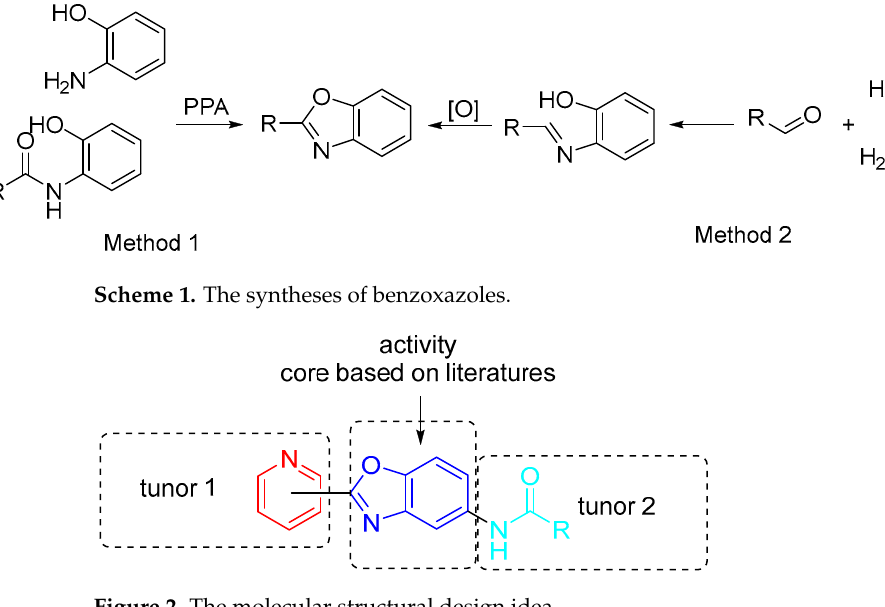
Figure 2. The molecular structural design